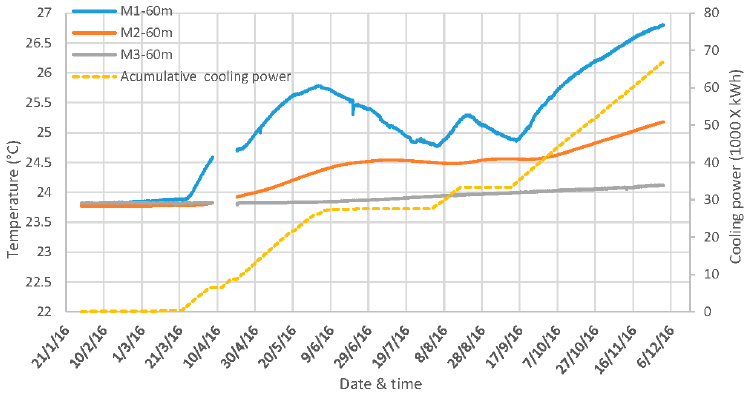
Figure 12. The ground temperature variation in the monitor boreholes of the CW system (M1, M2, M3) since the commission of the heat pump.